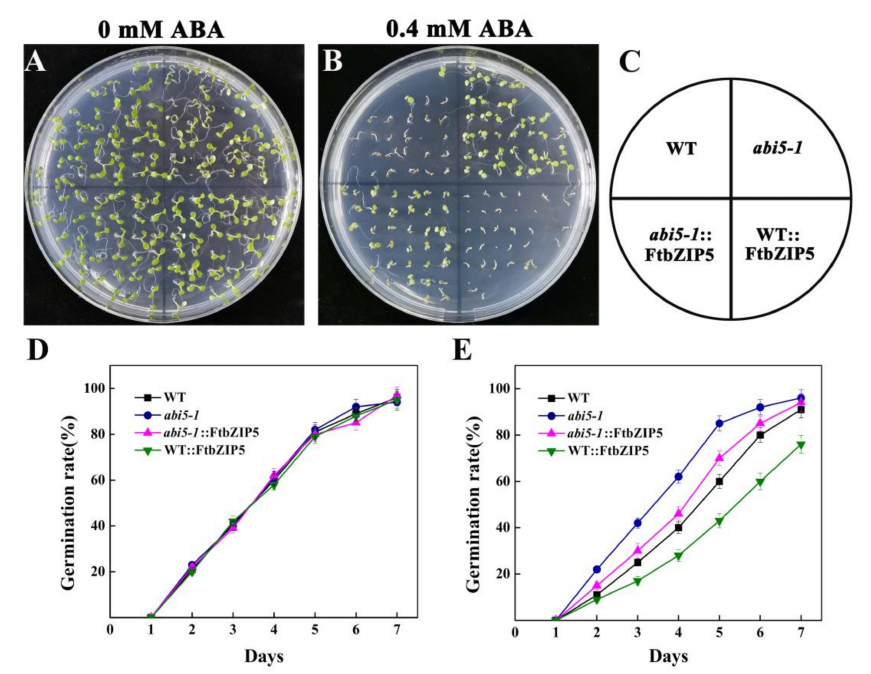
Figure 10. Ectopic expression of FtbZIP5 increases the ABA sensitivity of abi5-1 in Arabidopsis during seed germination. ( A , B ) The seeds of the WT, abi5-1 , abi5-1 :: FtbZIP5 and WT:: FtbZIP5 plants were cultured on 1 / 2-strength MS medium with 0 µ M ABA or 0.4 µ M ABA for 7 days. ( C ) A schematic map showing the four areas sown on the medium. ( D , E ) The germination rate of the seeds was